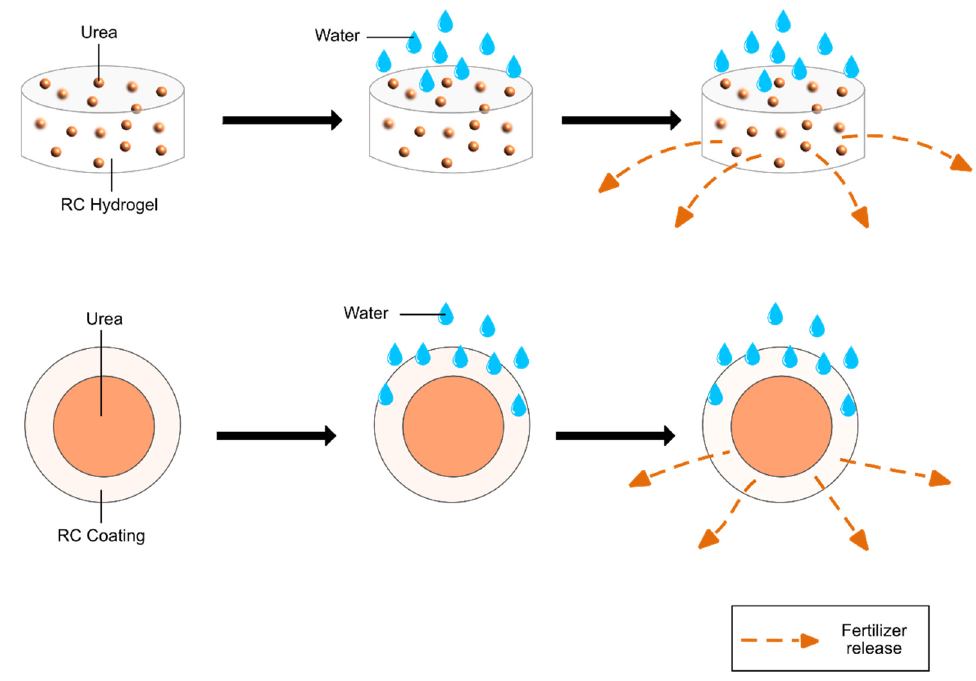
Figure 7. Illustration of RC hold/coat urea fertilizer. Table 6. Kinetic parameters of different types of RC hydrogels in